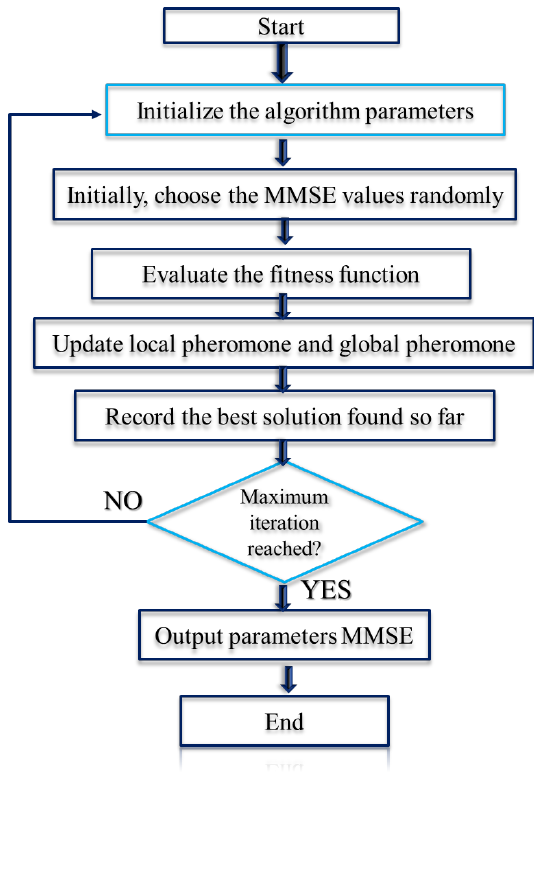
Figure 5: Flow chart for